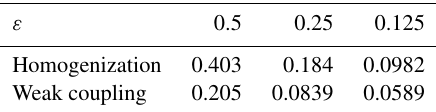
Table 1. The relative error on the mean exit time | E 1 (τ) − E E | / E 0 (τ) 0 (τ) where 0 (τ) is the mean exit time from the full triad system (Eq. 15) and E 1 (τ) is the mean exit time of the parameterized systems of Eqs. (18) and (16), with B ( 0 ) = − 0 . 75, B ( 1 ) = − 0 . 25, B ( 2 ) = 1, ω = 0 . 25, γ 1 = 1 /δ , σ 1 = √ and σ 2 = 2 with δ = 0 . 75. These values are calculated from 1000 independent trials.